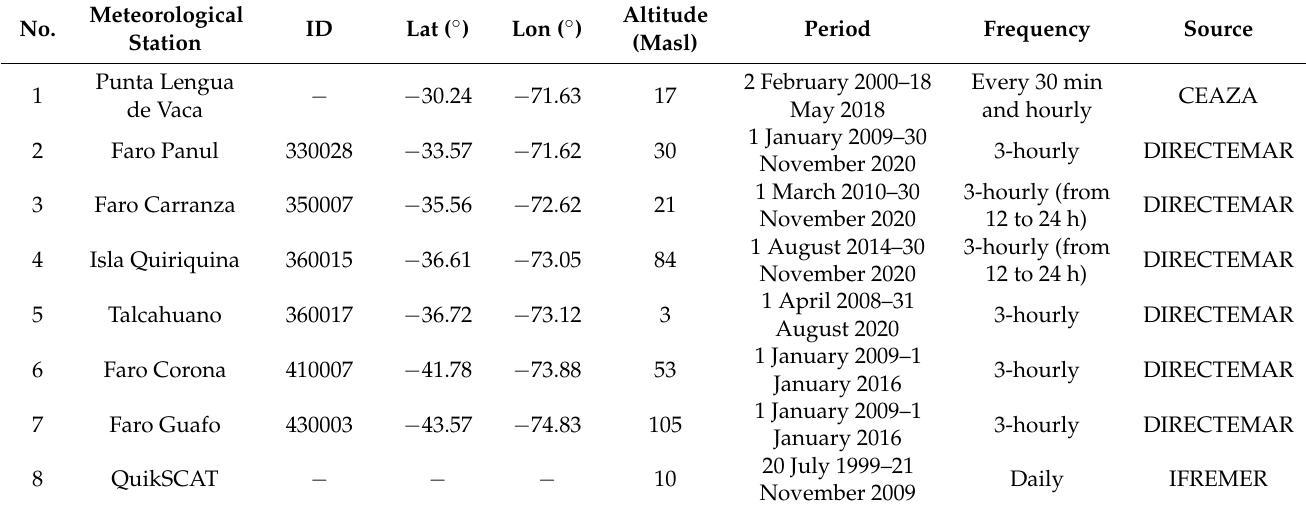
Table 1. Information and details of meteorological stations and satellite data used in this